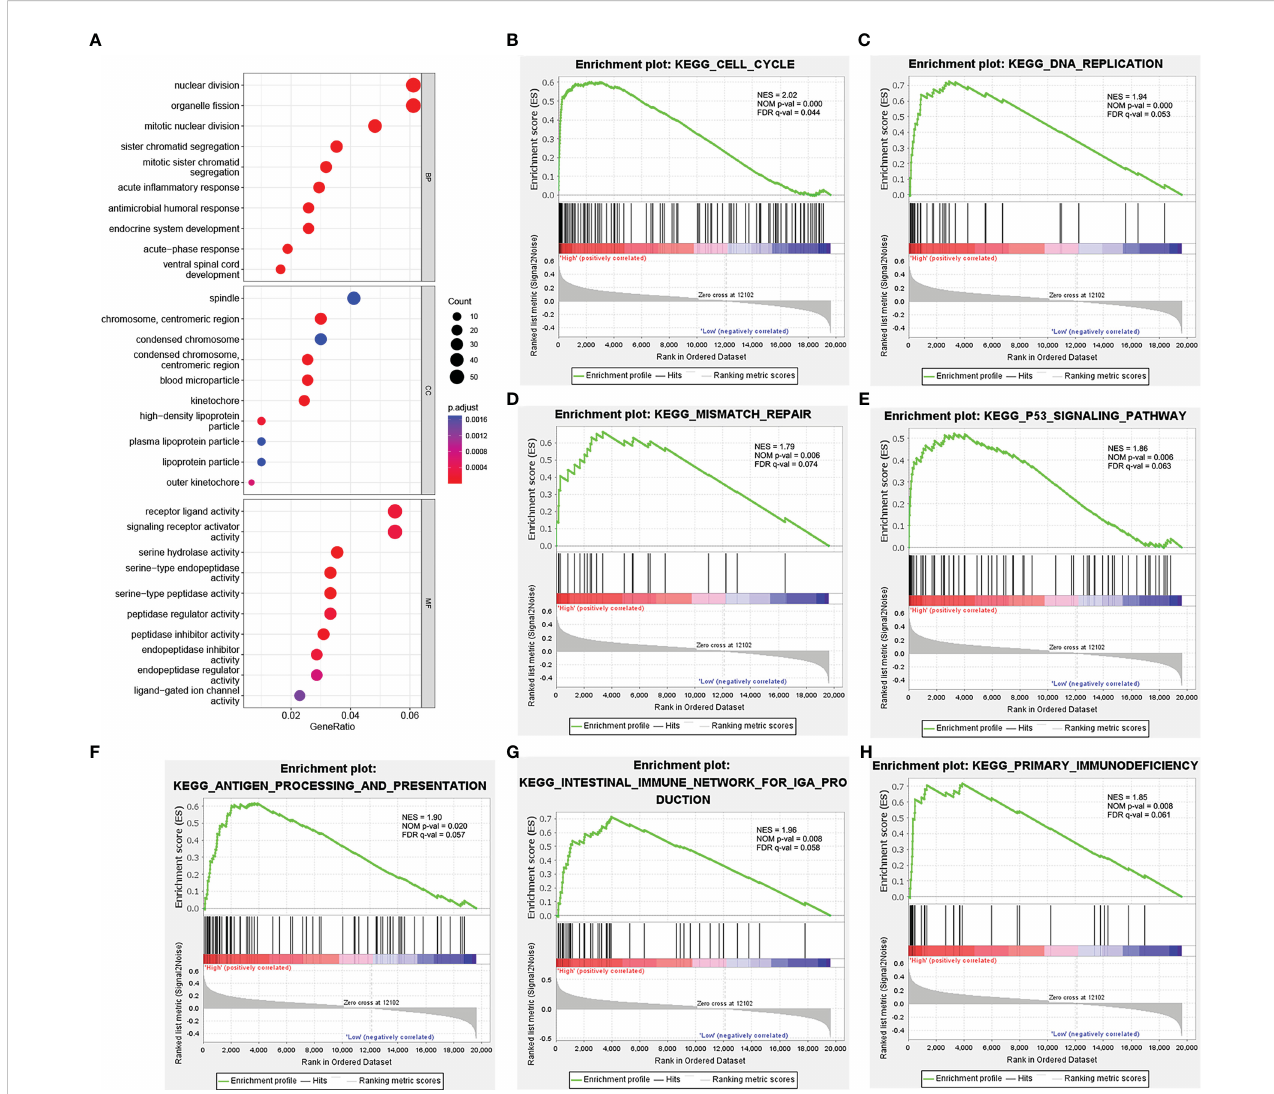
FIGURE 4 Functional enrichment analysis of NEIL3. (A) Enrichment plot from the GO analysis. Some biological processes (BP), cellular components (CC), and molecular functions (MF) were associated with NEIL3-related genes. (B – H) Enrichment plots from gene set enrichment analysis (GSEA). The GSEA results showed that the terms “ Cell cycle ” , “ DNA replication ” , “ Mismatch repair ” , “ p53 signal pathway ” , “ Antigen processing and presentation ” , “ Intestinal immune network for IgA production ” , and “ Primary immunode fi ciency ” were differentially enriched in NEIL3 high expression phenotype. NES, normalized enrichment score; NOM p-value, nominal P value; FDR, false discovery